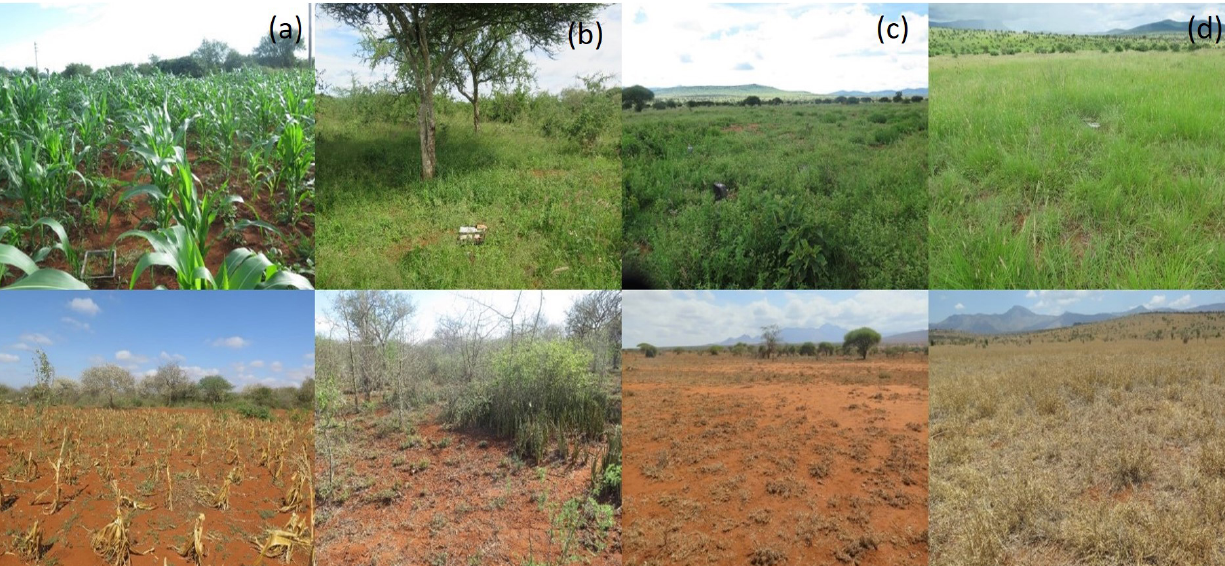
Figure 2. The four land-use types: (a) cropland, (b) bushland, (c) grazing land, and (d) conservation land. The upper row shows the land-use types during the wet season, while the lower row depicts the situation during the dry season. The grey plastic collar visible in the upper left photo is a frame for a GHG flux